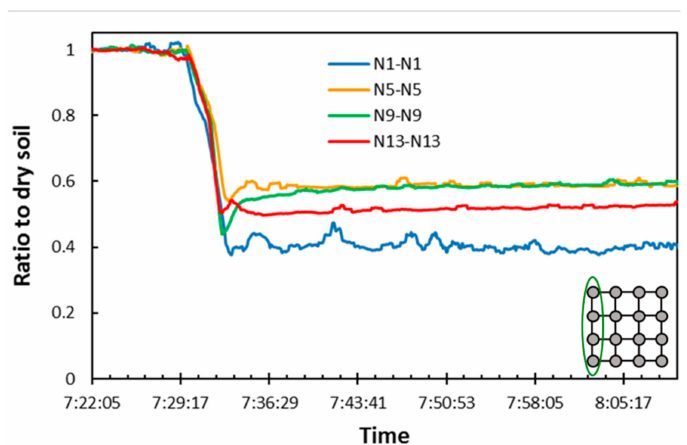
Figure 10. The relative resistance measured between electrode pairs #1, #5, #9, #13. While most of the water propagated to the bottom of the container, some accumulated near electrode #13, where it was initially applied and did not propagate downward for a relatively long time.